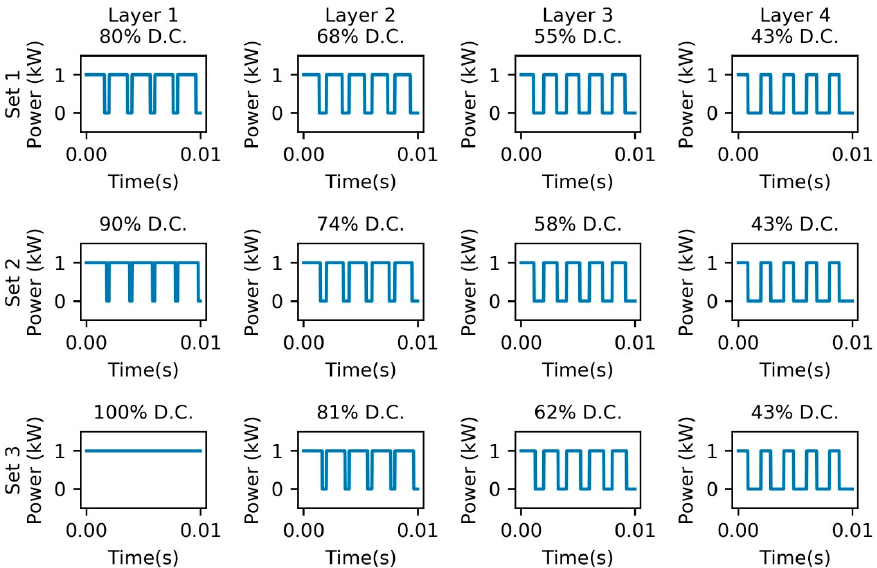
Figure 2. Power and duty cycle (D.C.) values used in the initial four layers at the dissimilar material interface while fabricating the copper–nickel FGM thin-wall deposits.